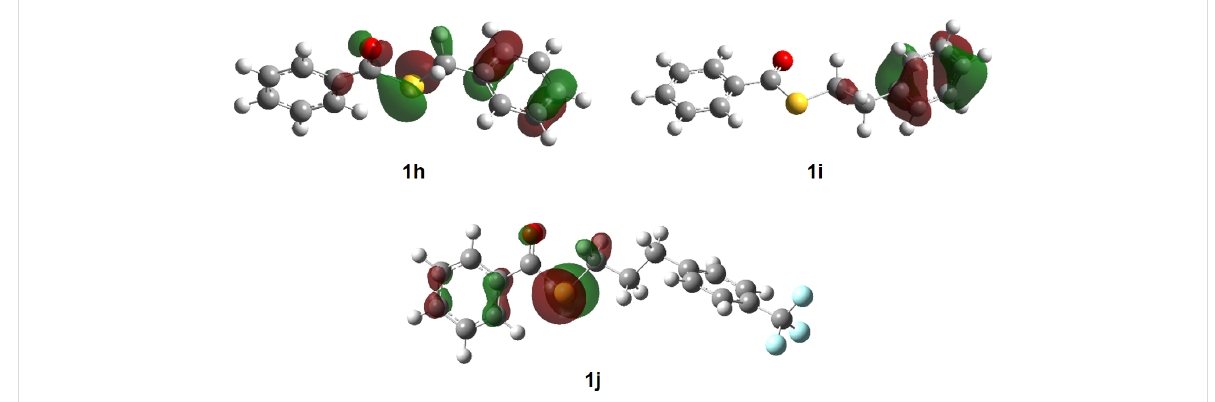
Figure 3: Calculated HOMO diagrams of 1h , 1i and 1j